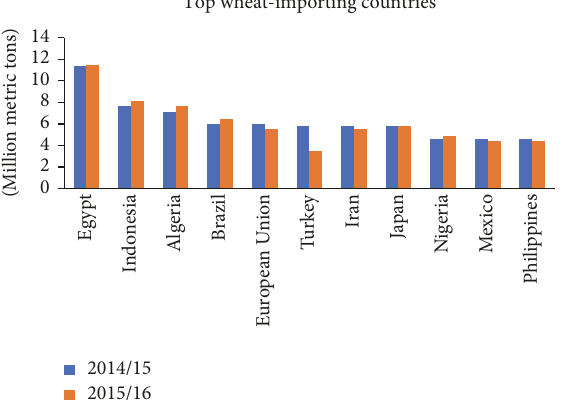
Figure 5: Principal importing countries of wheat, flour, and wheat products. Source : USDA, Foreign Agricultural Service, June 2015 [4].